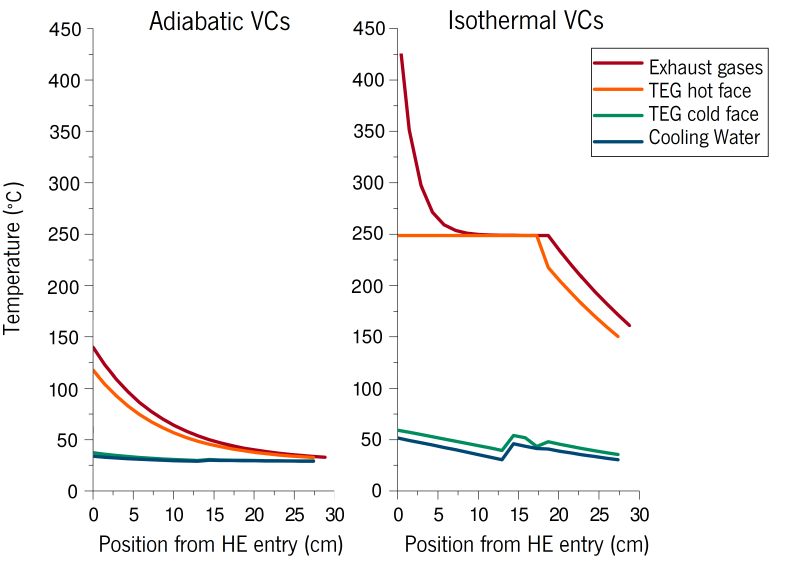
Figure 9. Sample temperature balance performed to the vapour chambers along the length of the Heat Exchanger, for a low thermal load (Adiabatic VCs) (WHVC FULL 187s) and a high thermal load event (Isothermal VCs) (WHVC FULL 1296s), with detail of the heat absorbed (corresponding to vaporisation), heat released (corresponding to condensation) and heat accumulation (net vapour mass